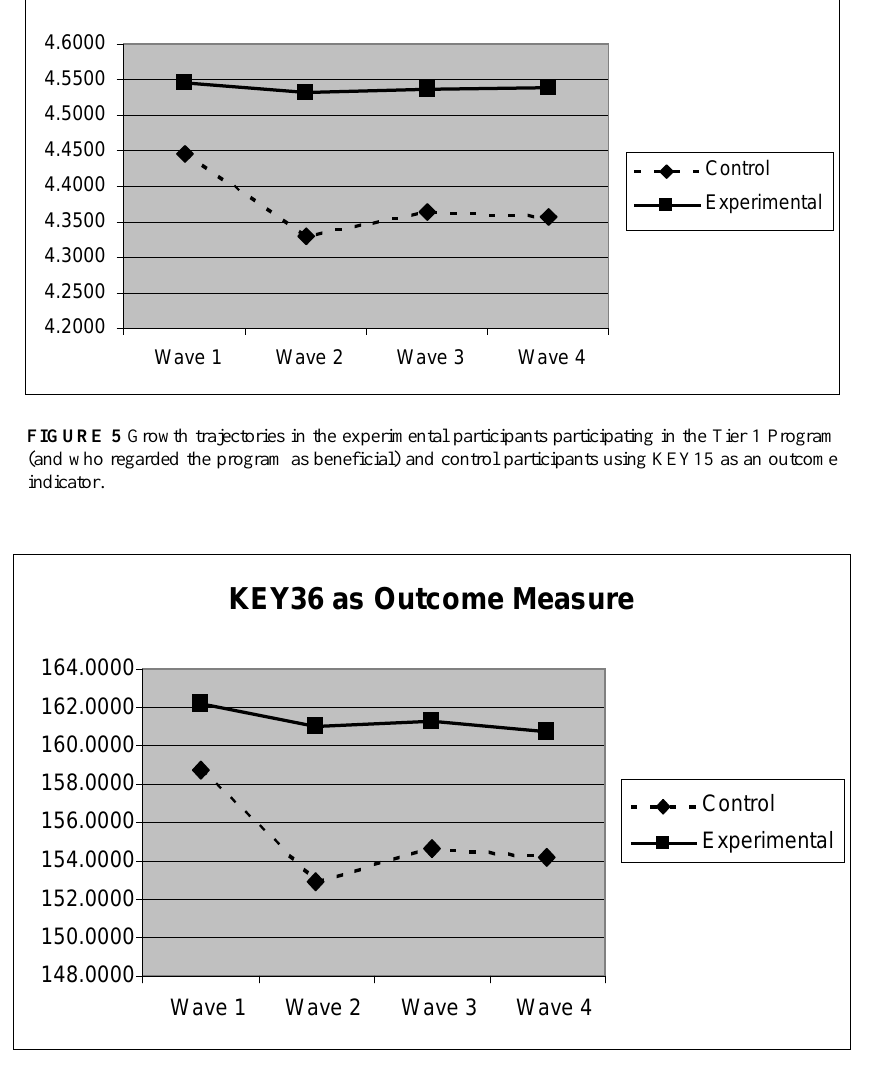
FIGURE 6. Growth trajectories in the experimental participants participating in the Tier 1 Program (and who regarded the program as beneficial) and control participants using KEY36 as an outcome